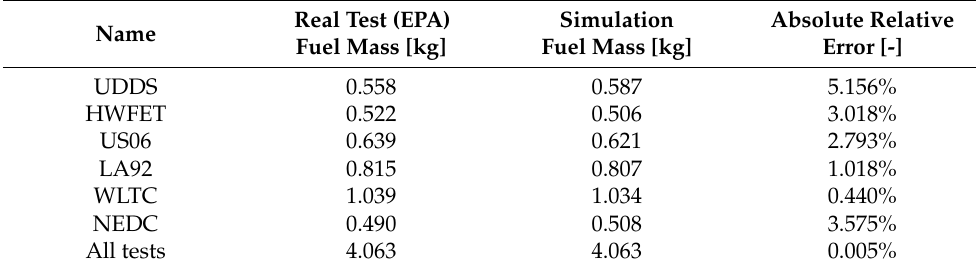
Table 4. Summary of final fuel consumption values for the real tests carried out (EPA) and obtained from the developed simulation of the 2018 Toyota Camry LE vehicle for selected road tests.